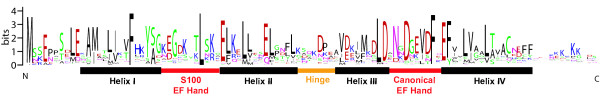
Amino acid sequence conservation in the fish s100 gene repertoire. Conservation is displayed as a sequence logo. In this representation, the relative frequency with which an amino acid appears at a given position is reflected by the height of its one-letter amino acid code in the logo, with the total height at a given position proportional to the level of sequence conservation. The regions corresponding to the Helices (H), the S100 EF Hand Calcium-binding domain, the Hinge and the Calcium-binding domain of the canonical EF Hand are numbered and indicated. Sequence alignments were manually edited (for details see Methods section).